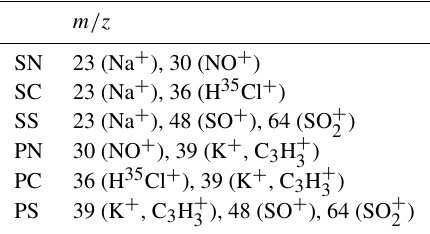
Table 2. Major m/z signals for each